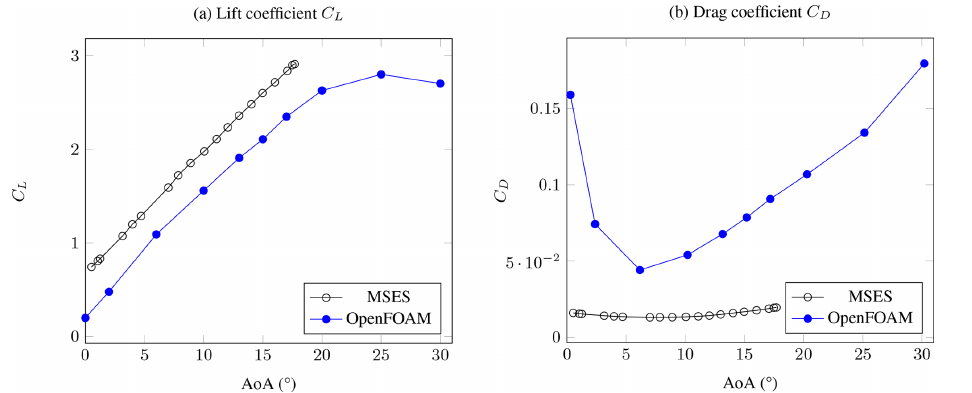
Figure 5. Comparison of (a) C L and (b) C D with different AoAs between MSES and OpenFOAM.